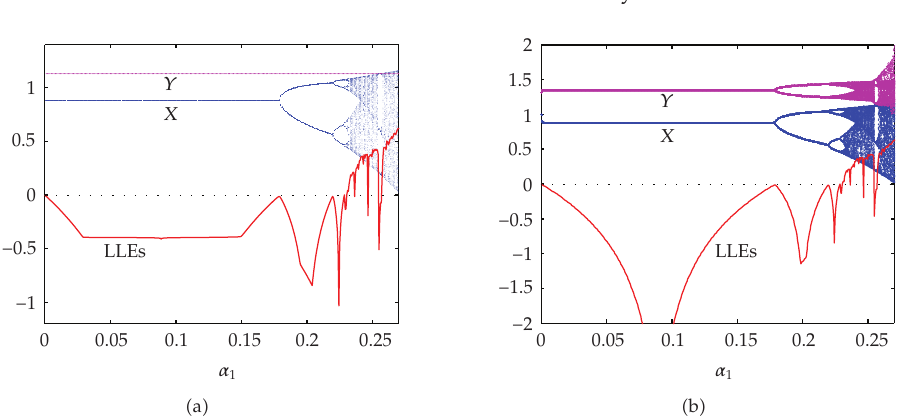
Figure 2: (cid:2) a (cid:3) The largest Lyapunov exponents and bifurcation diagram of system (cid:2) 4.4 (cid:3) versus α 1 ∈ (cid:4) 0 , 0 . 27 (cid:5) ; (cid:2) b (cid:3) the largest Lyapunov exponents and bifurcation diagram of system (cid:2) 5.3 (cid:3) versus k (cid:7) 0 . 2 and α 1 ∈ (cid:4) 0 , 0 . 27 (cid:5) .